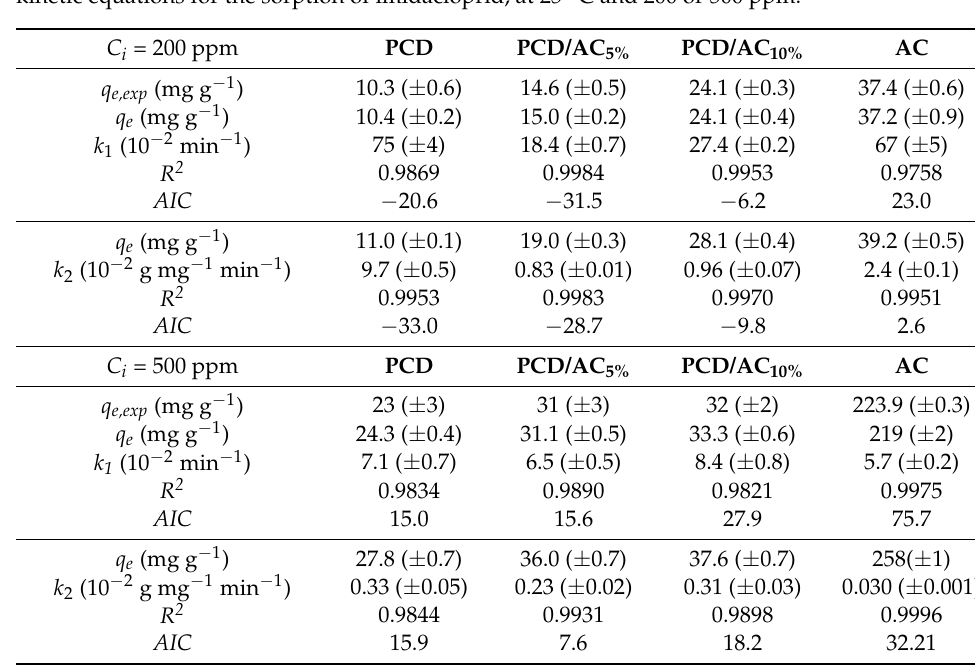
Figure 3. Sorption kinetic of imidacloprid (IMD) solution at 200 ppm ( a ) and 500 ppm ( b ); and cymoxanil (CYM) solution at 200 ppm ( c ) and 500 ppm ( d ) onto PCD/AC 10%. Solid and dashed lines represent the fitting of Equations (7) and (8), respectively, to the experimental data, at 25 ◦ C. The fitting parameters are shown in Tables 3 and 4. Table 3. Fitting parameters for the fitting of pseudo-first order (up) and pseudo-second order (down) kinetic equations for the sorption of imidacloprid, at 25 ◦ C and 200 or 500